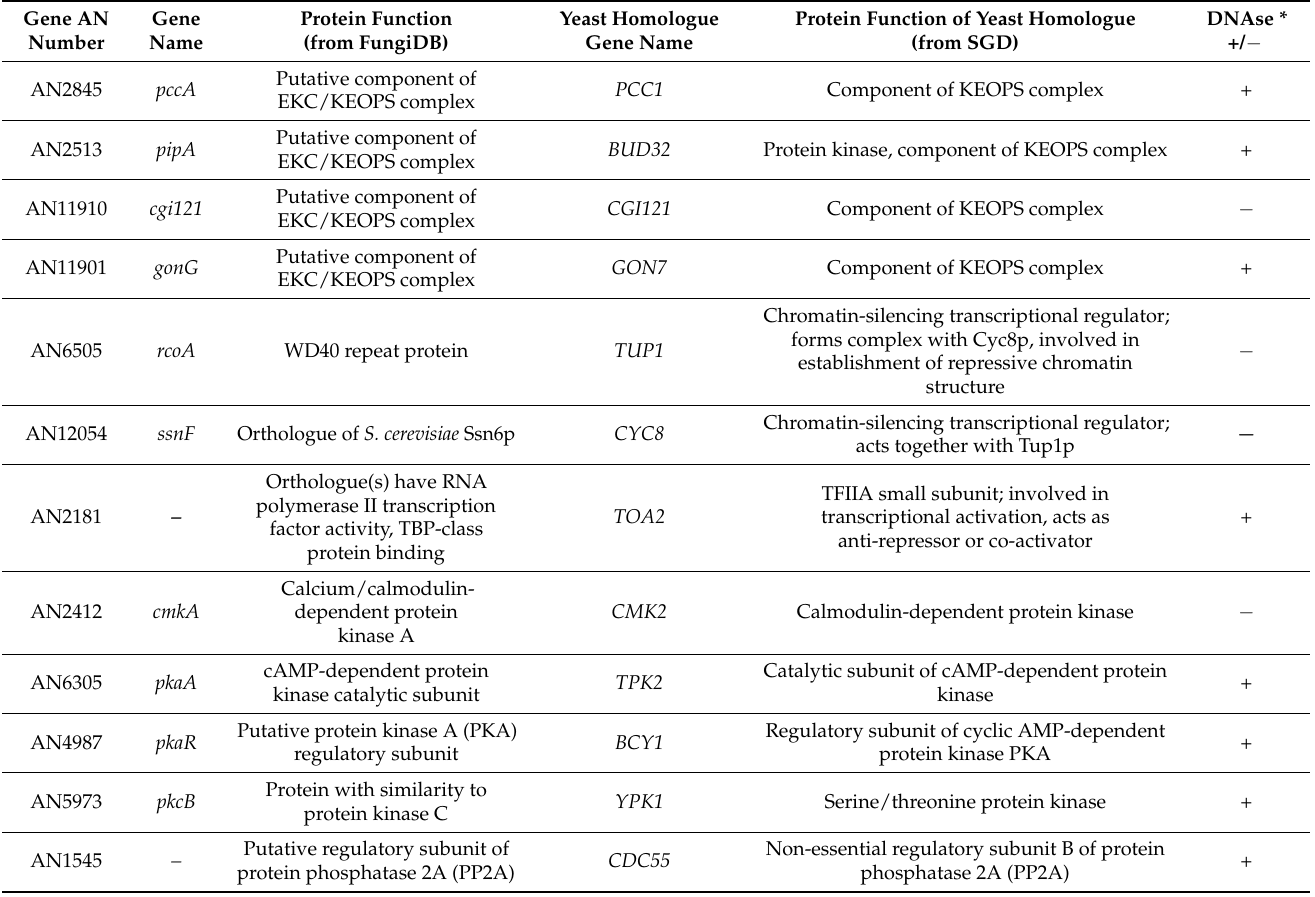
Table 2. Potential protein partners of